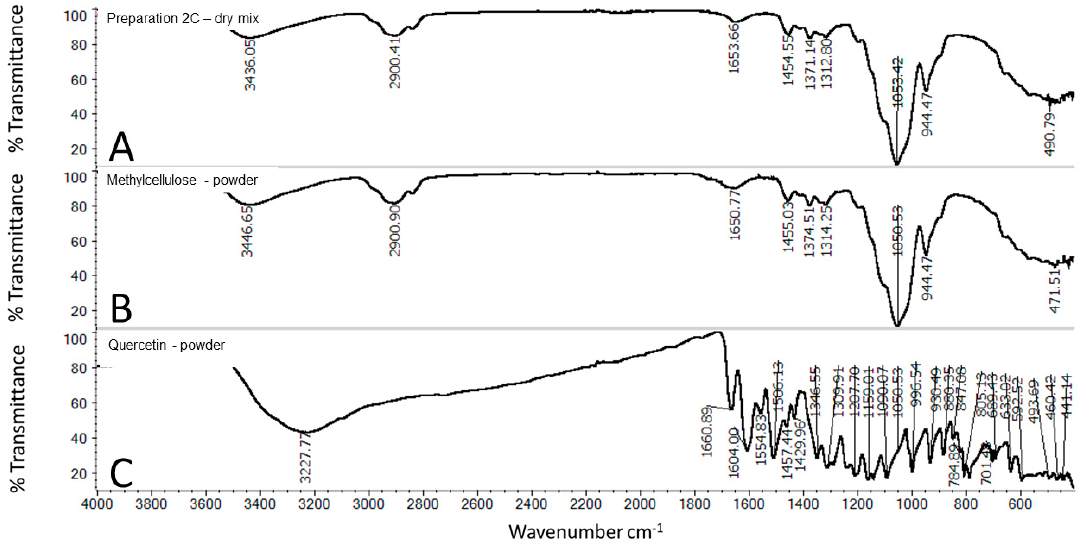
Figure 9. FTIR spectra of: physical mixture ( A ) of quercetin powder and MC in ratios reflecting the composition of 2C, MC ( B ), and quercetin ( C